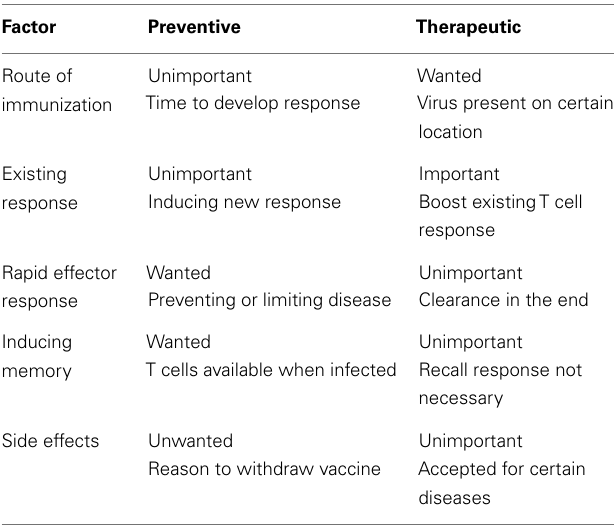
Table 2 | Design of a peptide-based vaccine for preventive or therapeutic